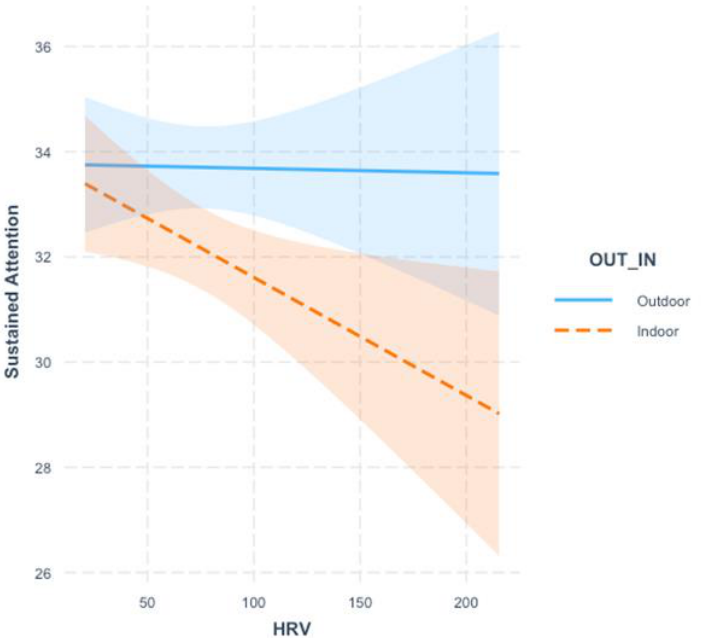
Figure 2. Simple Slopes for the Interaction Between Environment (Outdoor vs. Classroom) and Heart Rate Variability (HRV) on Children’s Sustained